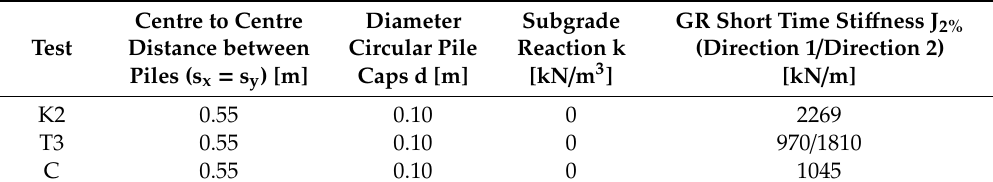
Table 1. Parameters of the Dutch tests.